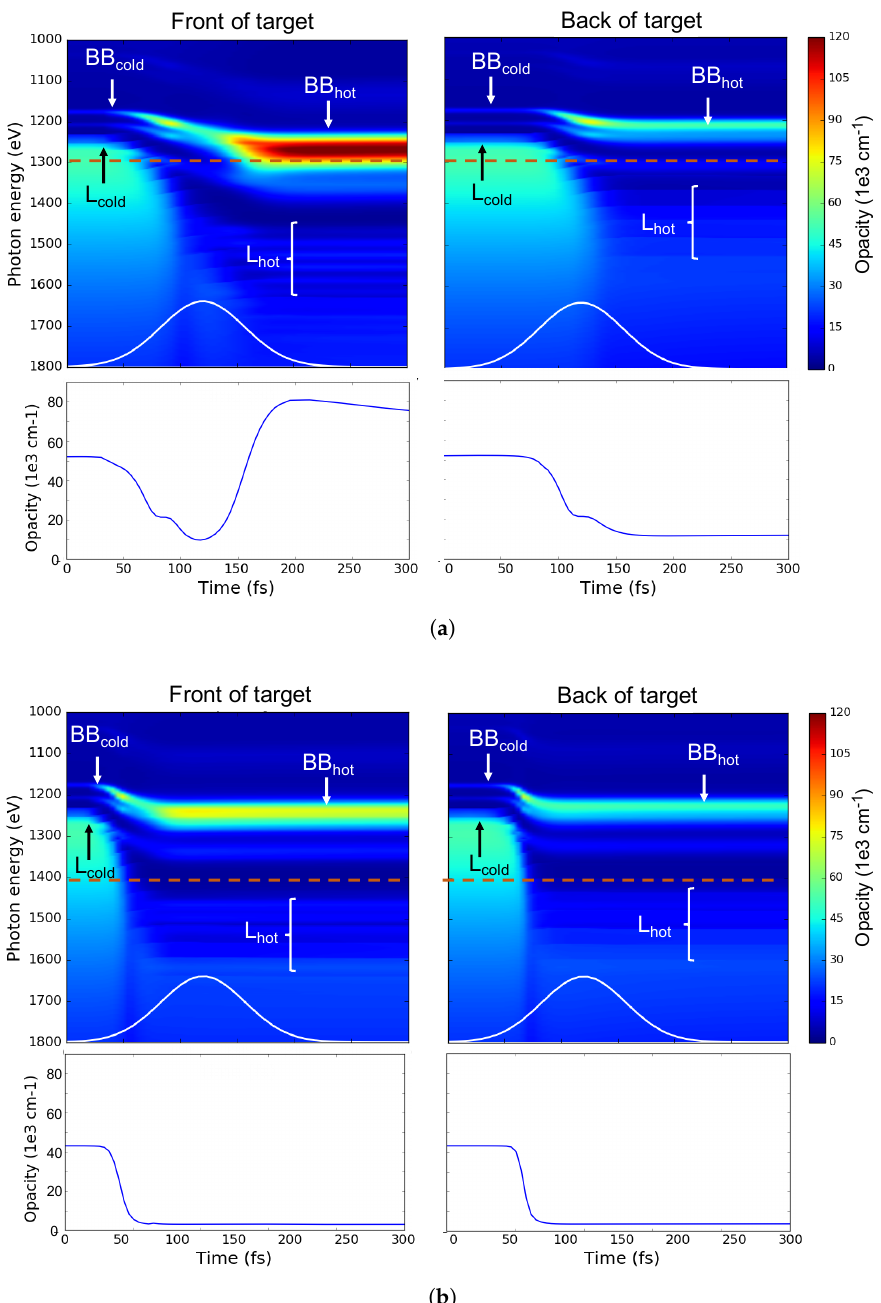
Figure 4. Cretin simulations of the opacity at the front and back of the targets for XFEL photon energies of 1300eV ( a ) and 1400eV ( b ). The orange dashed lines indicate the photon energy of the XFEL in each case, and the laser pulse is shown in white. Additionally, the position of the bound-bound transitions and the L-edges for the cold and hot case are indicated. Each of the inset plots below the figures show a more detailed lineout of the plasma opacity at the photon energy of the XFEL as a function of time. In the 1300eV case, as the plasma heats up owing to the effect of the XFEL, the bound-bound features shift up in energy until they overlap with the XFEL energy, and thus absorption becomes much more efficient. In contrast, in the 1400eV case, the XFEL photon energy lies above that of the bound-bound transitions, but below the L-edges of the ions produced as the plasma is heated, thus leading to reduced